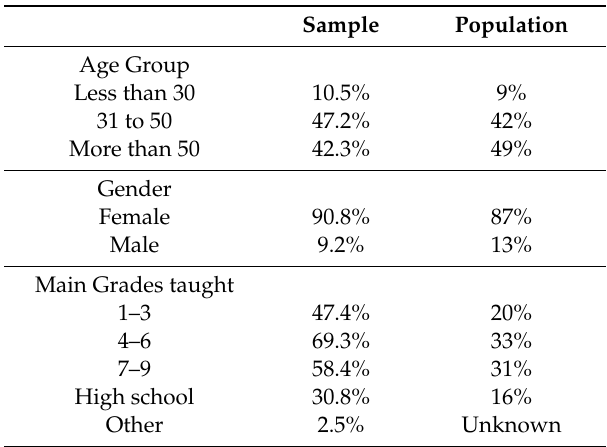
Table 1. Sample and population